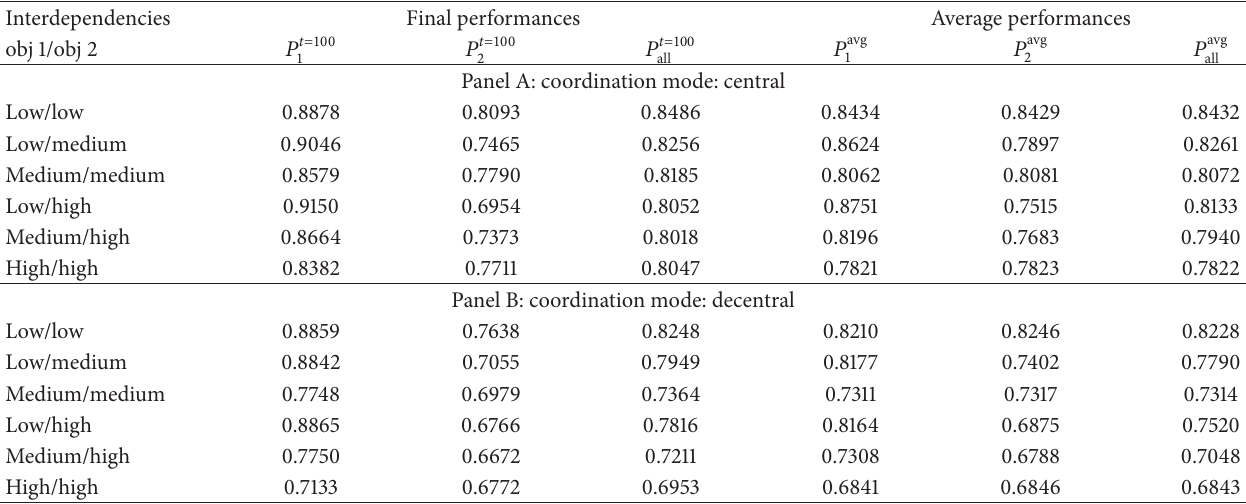
Table 5: Short-run